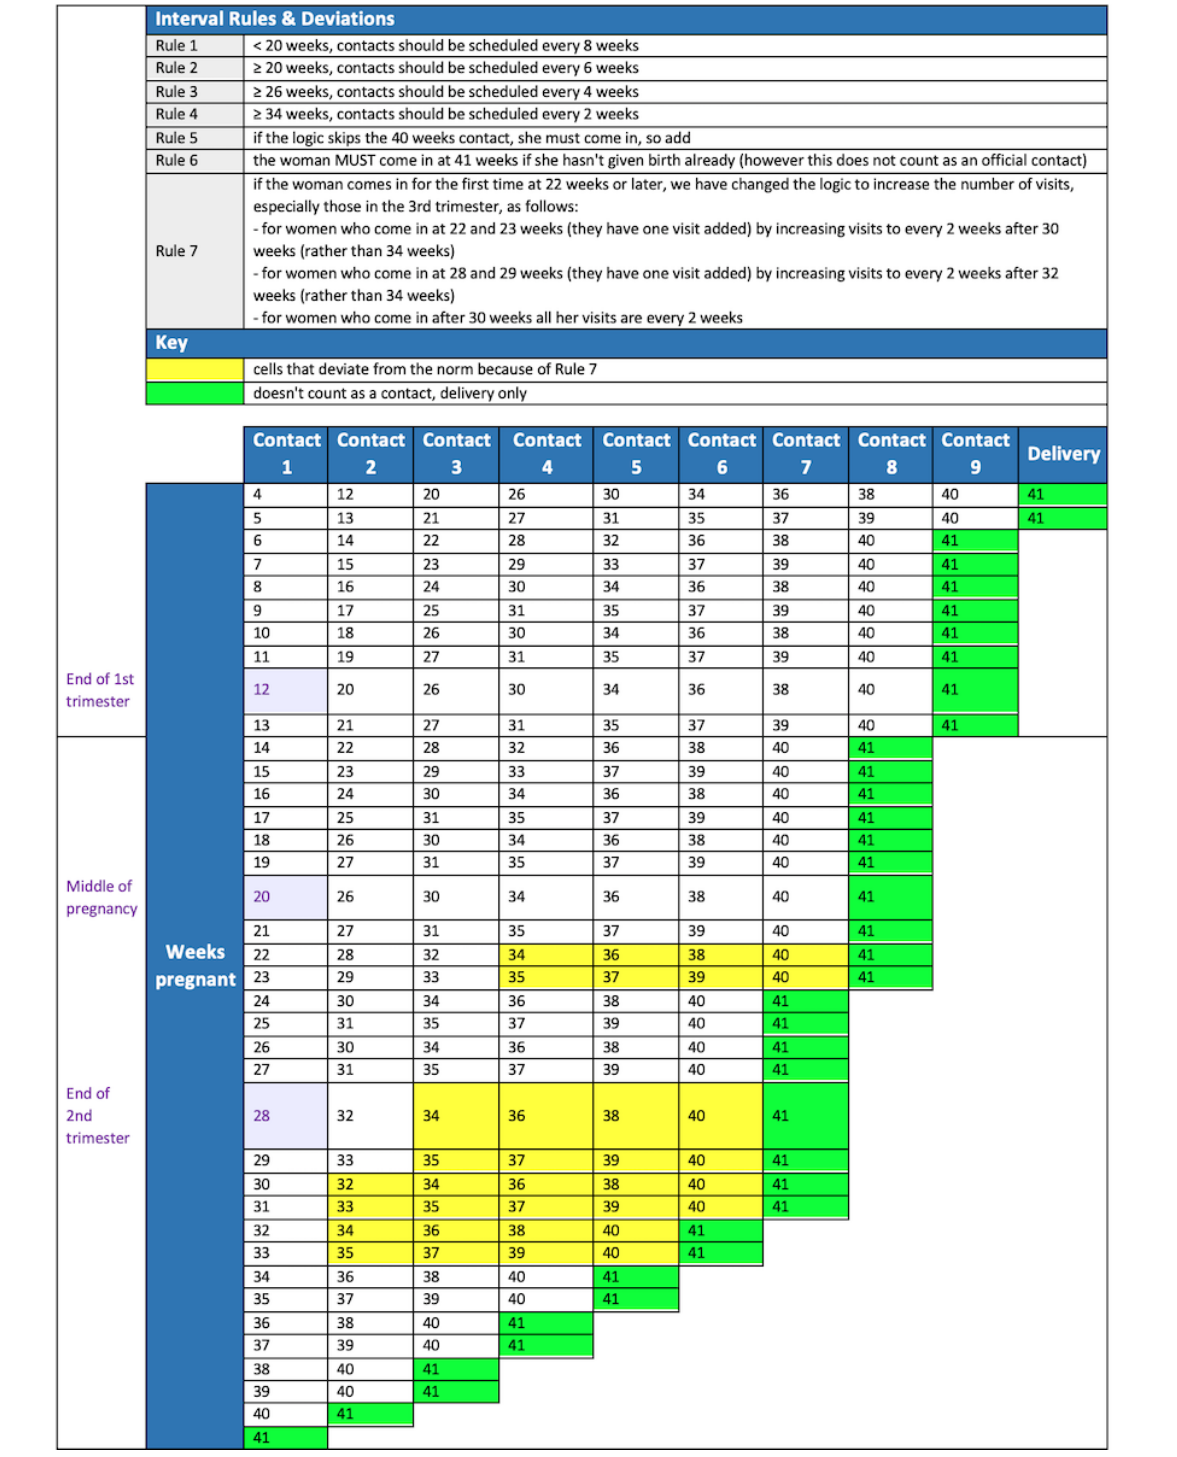
Figure 2. Antenatal care (ANC) 8-contact delivery